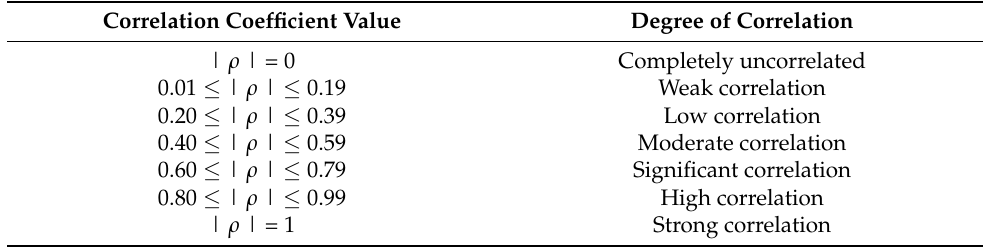
Table 1. Spearman’s correlation degree classification table.